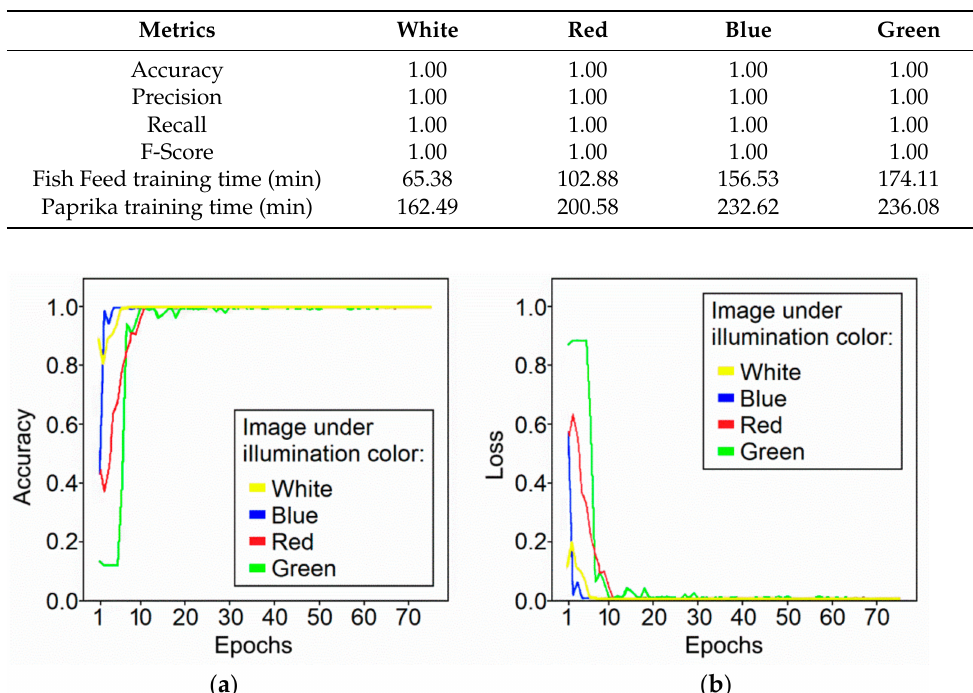
Figure 9. ROC curve obtained in the CNN performance evaluation (all colors). Note: all classes overlap in the horizontal line. Table 3. Performance measures of the CNN as classifier for each color dataset.